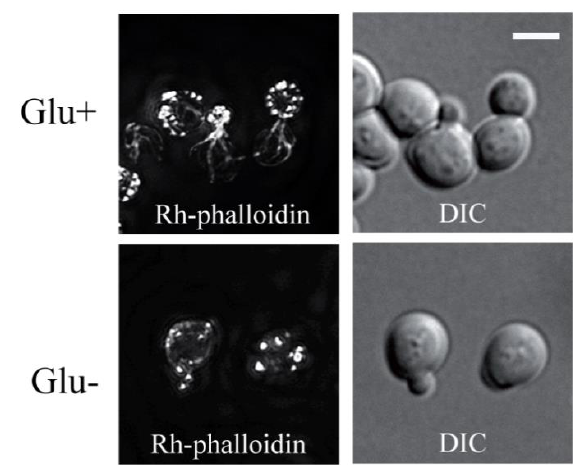
FIGURE 1: The F-actin stained with rhodamine-tagged phalloidin in exponentially growing S. cerevisiae (rho+) cells (strain CRY339; Z-stack). Cells were fixed with 3.7 % formaldehyde in the presence of glucose (HCHO-fixed) (Glu+), or after 30 minutes incubation in medium without glucose (Glu-). Bar, 5